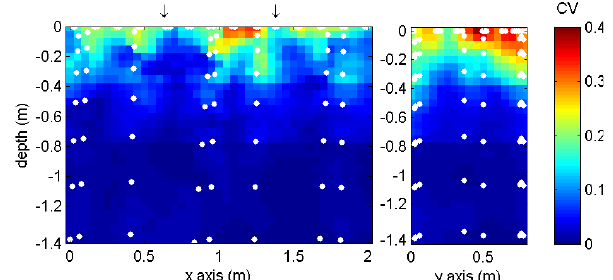
Fig. 11. SWC coefficient of variation for the first ERT measurement time (13 August 2009) on the x-axis (left), the y-axis (right). The arrows on the x-axis figure represent the maize row positions. The white dots correspond to the electrode positions.